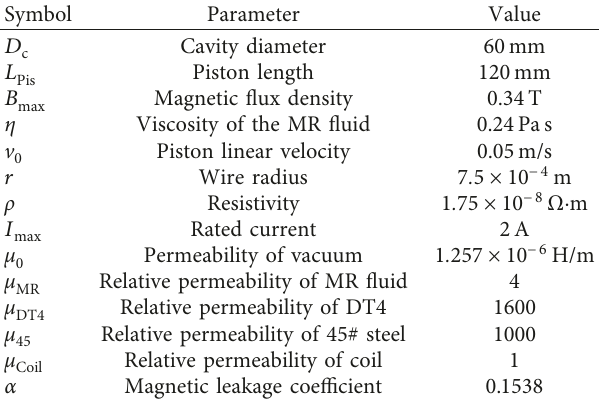
Figure 5: Equivalent magnetic circuit model. Table 1: Temperature and wildlife count in the three areas covered by the